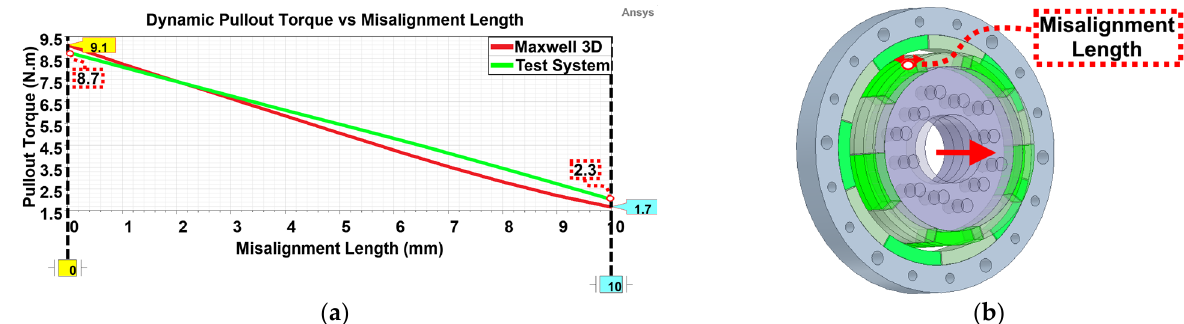
Figure 19. ( a ) Pullout torque depending on misalignment length; ( b ) Exhibition of misalignment.